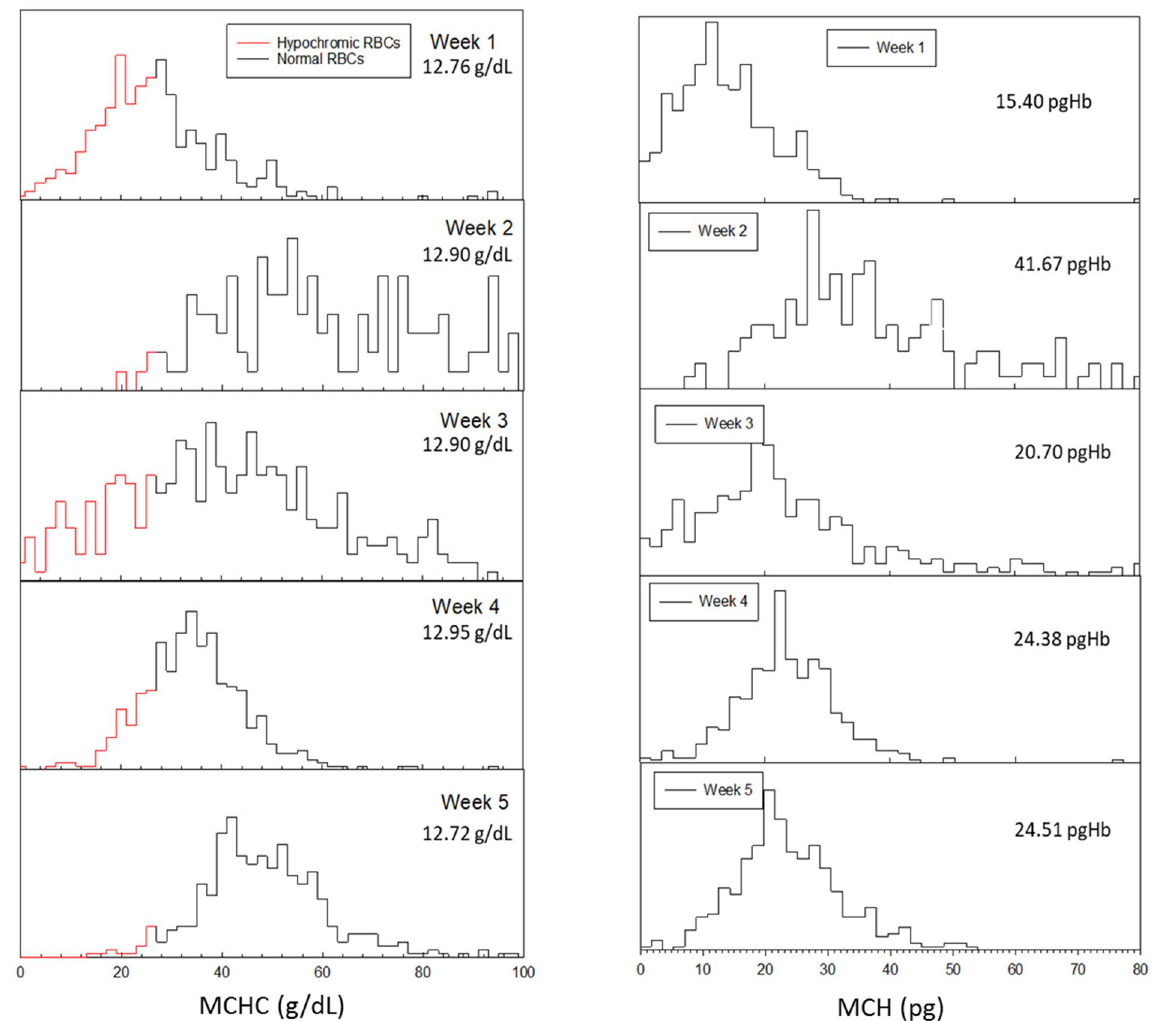
Figure 8. Weekly measurements of MCHC and MCH on CTV for healthy donor 6. Left panel presents MCHC CTV (red line shows the hypochromic RBCs and the numbers inside the graph report Hb spec ) and right panel shows MCH CTV (numbers inside the graphs report the average MCH CTV